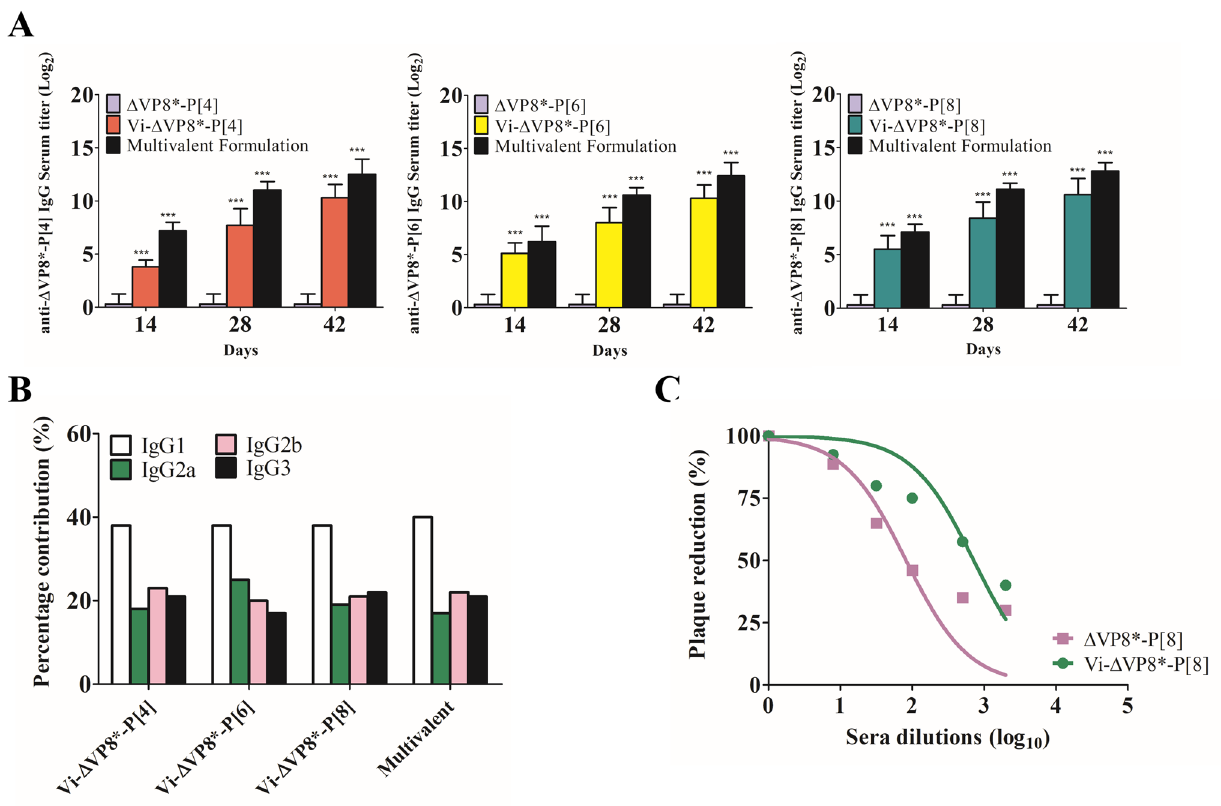
Figure 5. Immunogenicity study of Vi-ΔVP8* for anti-ΔVP8*. ( A ) IgG of mice immunized with ΔVP8* or Vi-ΔVP8* conjugates. ( B ) percentage contribution of IgG subclasses to total IgG against ΔVP8*. ( C ) Neutralization analysis of sera from immunized mice; Day 42 immune sera for titers were used. BALB/c mice were immunized S.C. with 5 μg of Vi-ΔVP8*-P[4], P[6] or P[8], or 15 μg of multivalent formulation based on Vi polysaccharide, 3 times at 2-week intervals as described in Methods. Data were analyzed and illustrated using GraphPad Prism 6.0 software (GraphPad, https:// graph pad. com); data are mean±s.d.; two sample t -test; * P <0.05, ** P <0.01, *** P